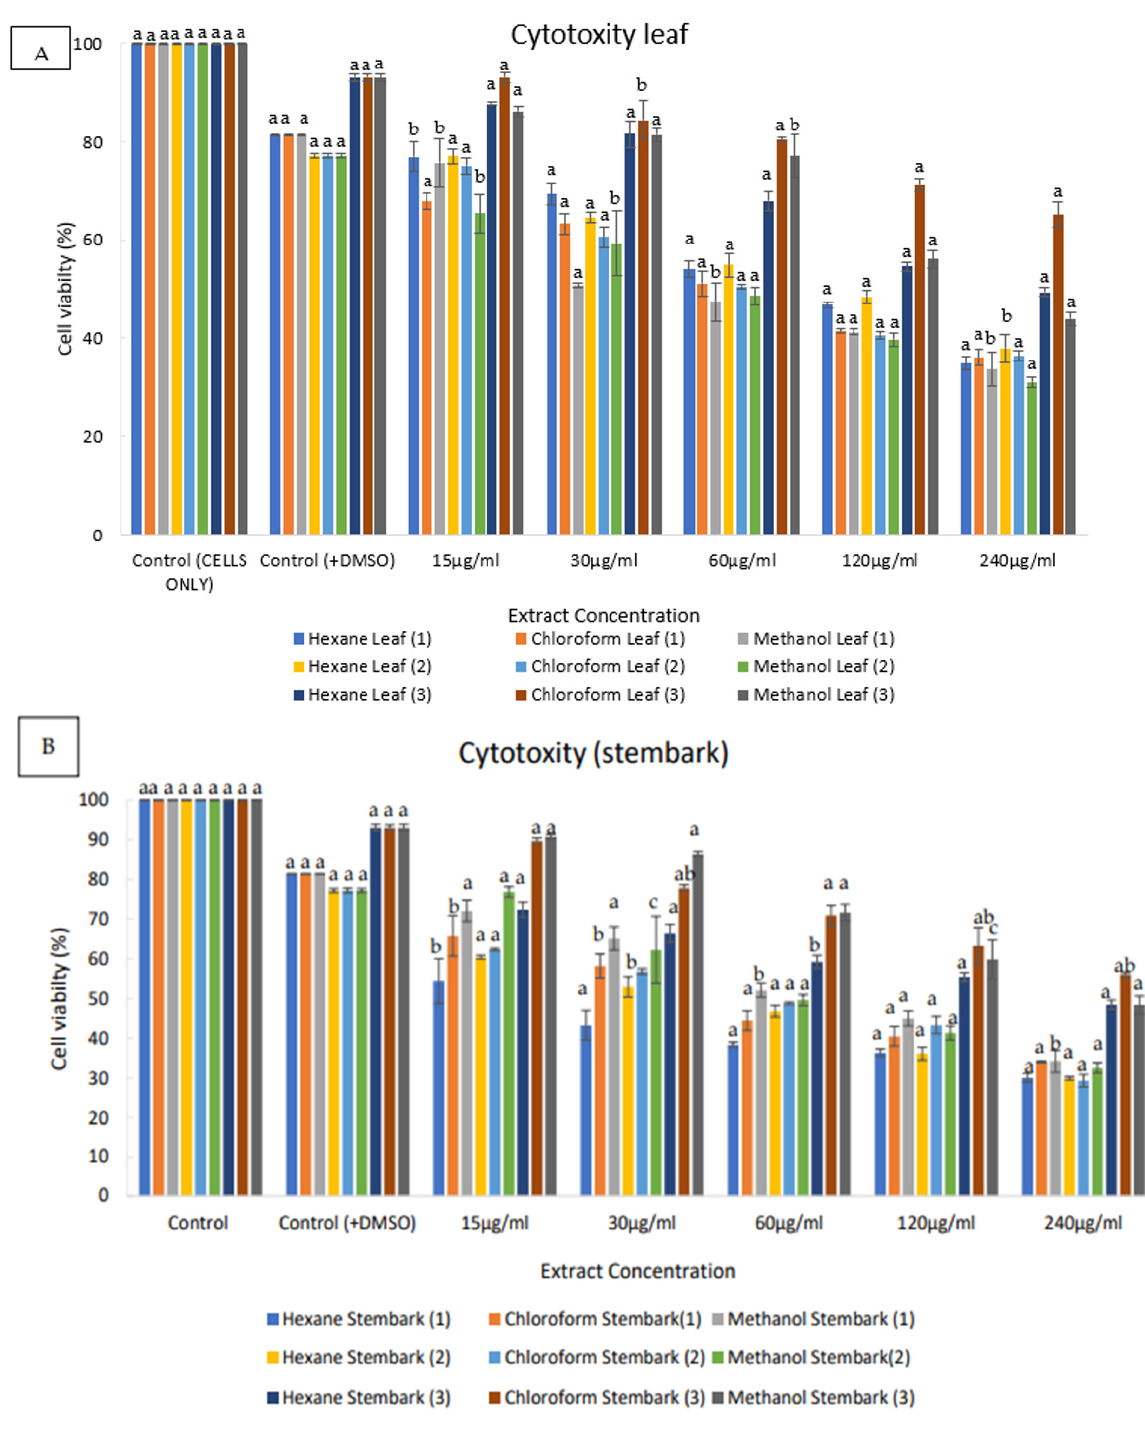
Figure 3. Cytotoxic activity of ( A ) leaf: hexane, chloroform, and methanolic, and ( B ) stembark: hexane, chloroform, and methanolic extracts of C. erythrophyllum , against three cell lines, HEK293 = (1), HeLa = (2) and MCF7 = (3). a–c letters above the bars indicate significantly different data (Tukey’s honest significant difference multiple range post hoc test p < 0.05 IBM SPSS version 27).